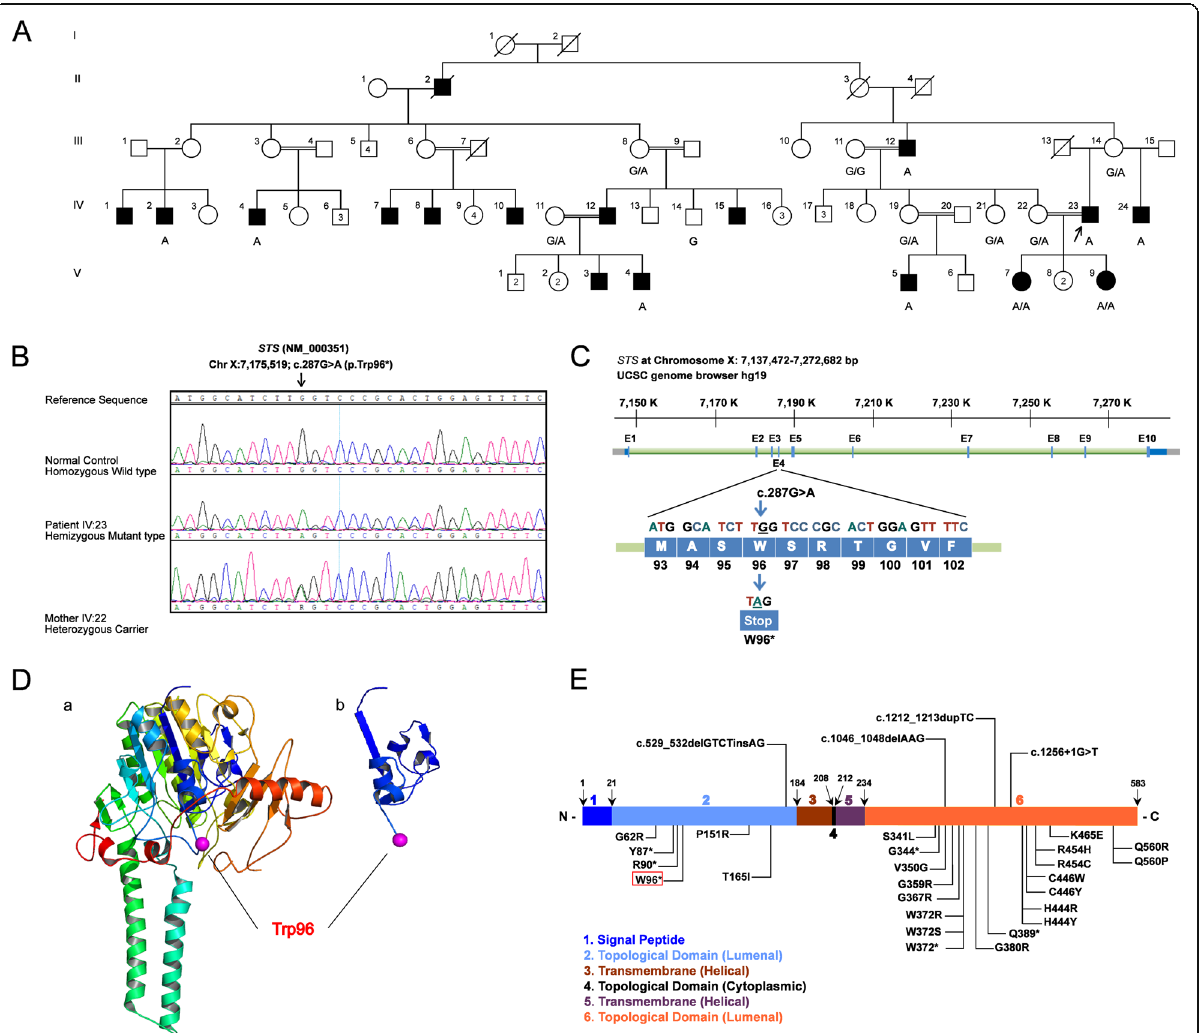
Fig. 1 Identification of a novel nonsense mutation in STS gene (A) Pedigree of the family with X-linked ichthyosis. The proband (IV:23) is noted with an arrow. ■ , affected male; ● , affected female; ◻ , healthy male; ○ , healthy female. (B) Sequencing chromatogram showing the wild type normal control hemizygous affected male and heterozygous female carrier, with mutation position marked by an arrow. (C) Schematic representation of exon-intron structure of STS gene; exons are designated as boxes E (1 – 10). DNA and protein sequence of the exon 4 where the mutation c.287G>A (p.W96*) resides is shown expanded. Nucleotide and amino acid numbering correspond to NM_000351 for the cDNA and NP_000342.2 for the protein. Nucleotides were numbered using A of the ATG translation initiation codon as +1 nucleotide of the coding sequence. (D) A ribbon diagram showing the secondary and tertiary structures of the wild type STS enzyme. Sheets are drawn in yellow, helices in red and loop regions in green. (a) showing β - sheets, α -helices and coils. The structure (b) denotes the potential truncated polypeptide (STS enzyme) due to p.W96* mutation (Swiss-Model). (E) Schematic illustration of the domain graph of the encoded STS protein (Uniprot identifier: P08842), and the genetic variants. A full-length wild type STS protein is shown, with its N-terminus and C-terminus. Novel variant identified in our study is boxed in red alongside previously reported point mutations and a splice- site variant underlying XLI phenotype in The Human Gene Mutation Database (HGMD®;